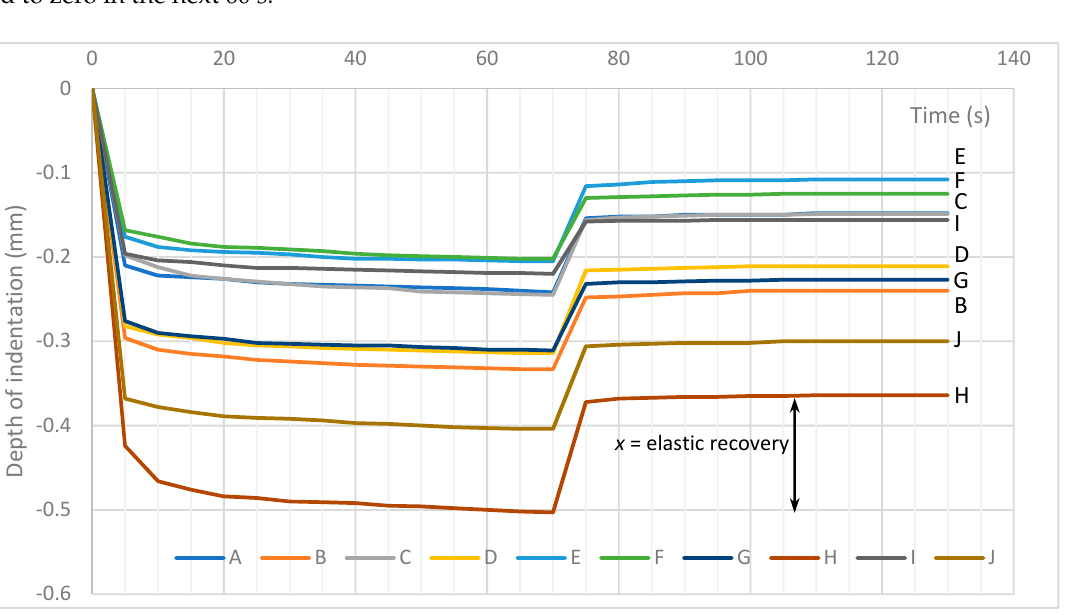
Figure 7. Variability of the indentation depth during the test.